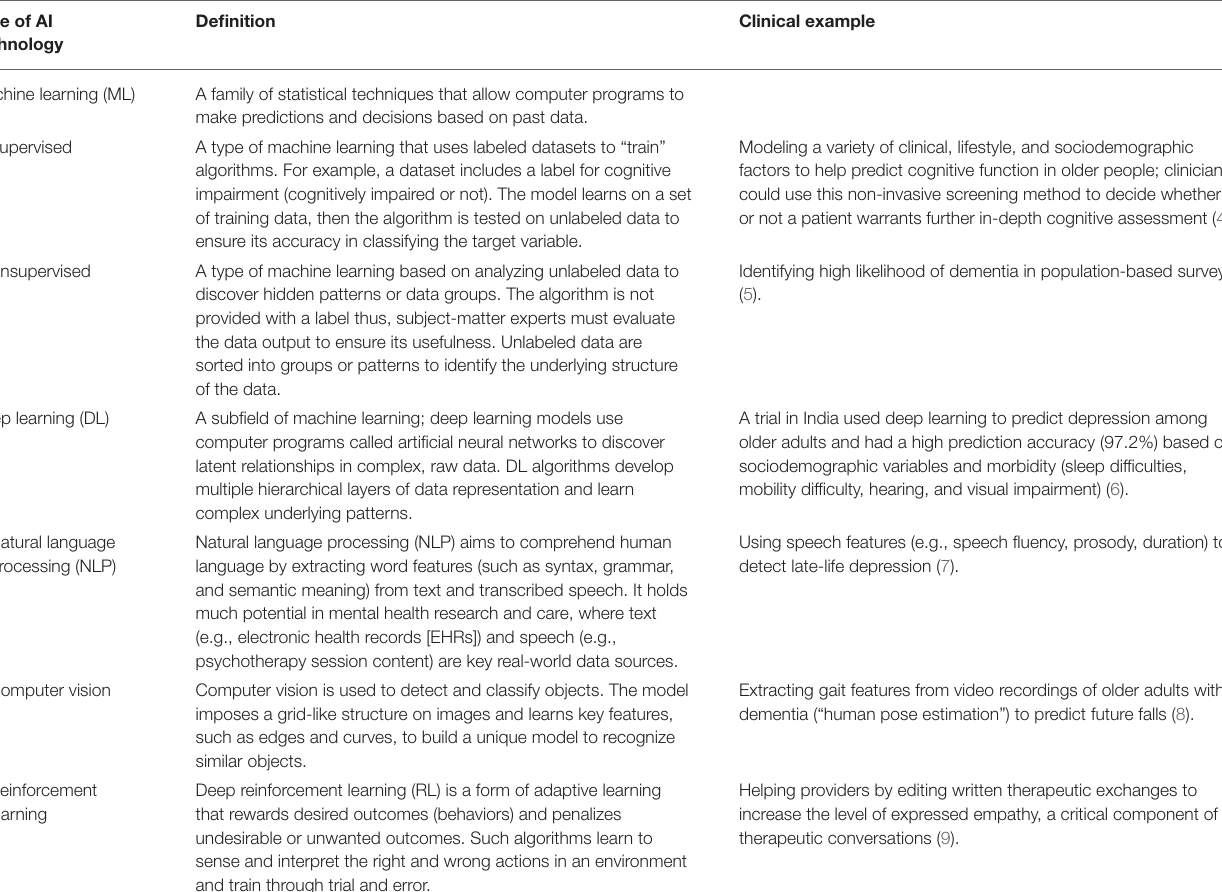
TABLE 1 | Overview of artificial intelligence (AI) technologies with relevance to geriatric mental